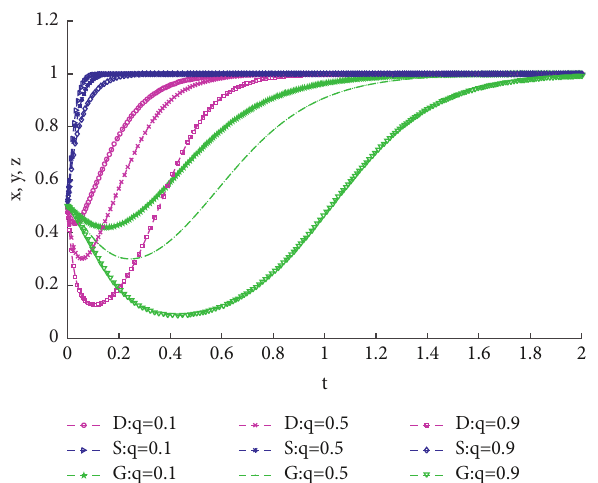
Figure 8: The evolutionary result of the historical changes in the interaction between the two parties of the service